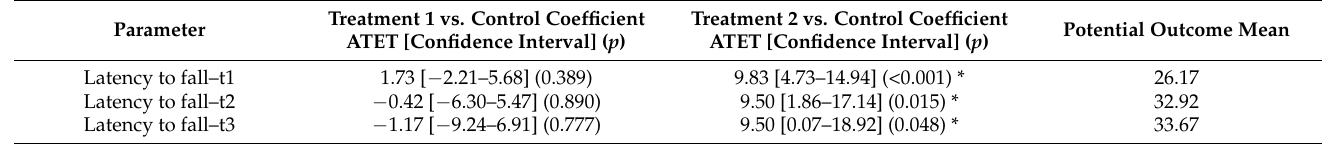
Table 8. Averaged treatment effects for rotarod tests.